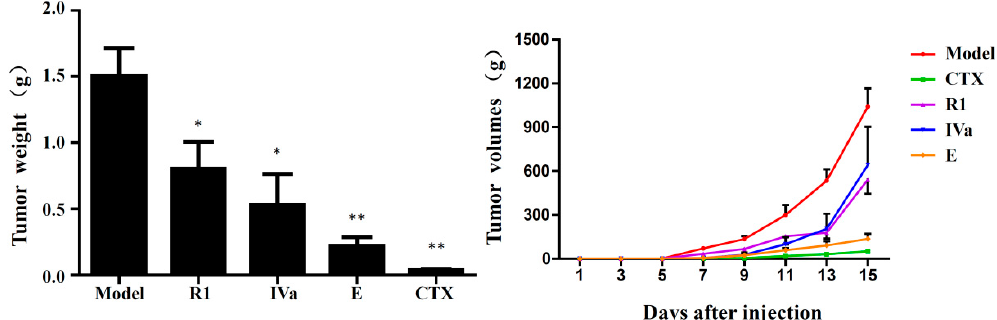
Figure 7. E ff ects of Ro metabolites on changes in tumour weight and tumour volume in B16F10 tumour xenograft mice. R1 (25 mg / kg), IVa (25 mg / kg), and E (5 mg / kg) were intraperitoneally injected into mice for 15 consecutive days. Values are expressed as the mean ± standard deviation (SD) of six mice.